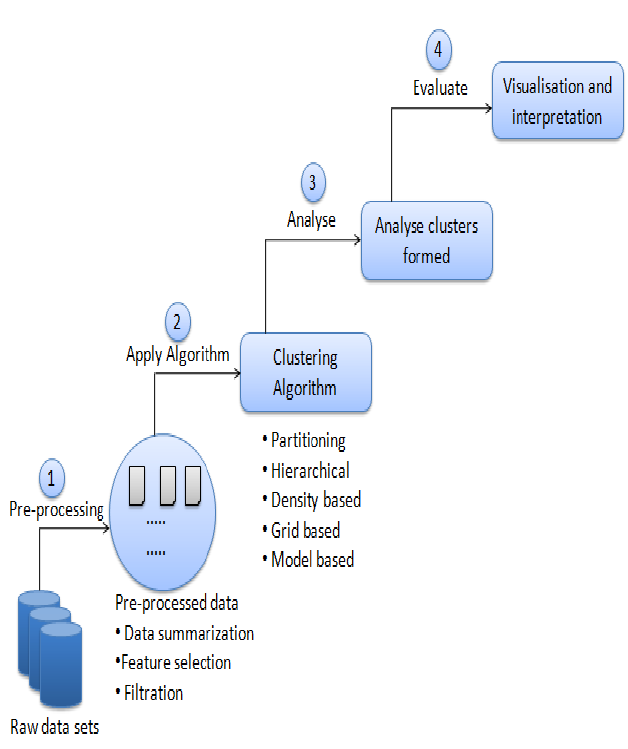
Fig.1. Formation and evaluation of clusters [3].